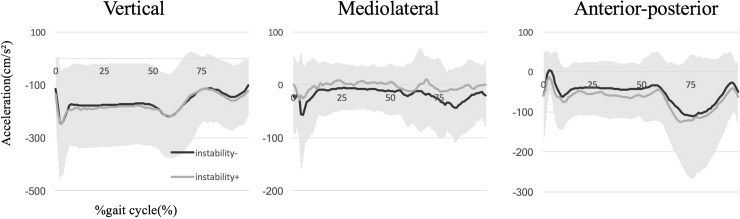
The average wave patterns of accelerations along three axes, including vertical (VT, positive superiorly), mediolateral (ML, positive medially), and anteroposterior (AP, positive anteriorly) directions between the groups with or without subjective instability, are shown.The colored range means standard deviation (SD) in all groups.